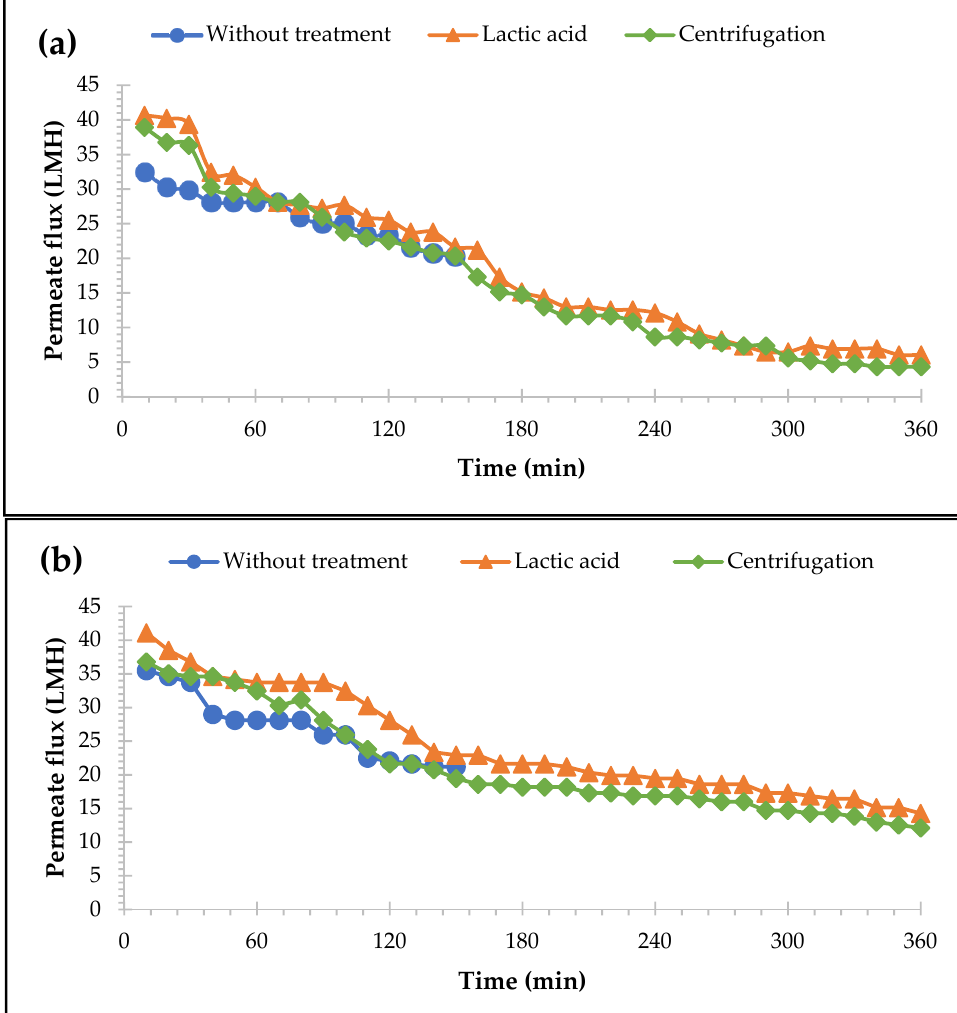
Figure 5. Effects of pre-treatments on the permeate flux of ( a ) MF membranes 0.2 µ m (CFV = 0.5 m/s and TMP = 0.8 bar) and ( b ) UF membranes 200 kDa (CFV = 1.0 m/s and TMP = 3 bar) with the function of time .